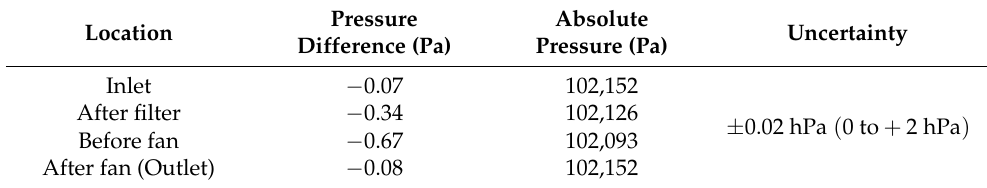
Table 3. Pressure